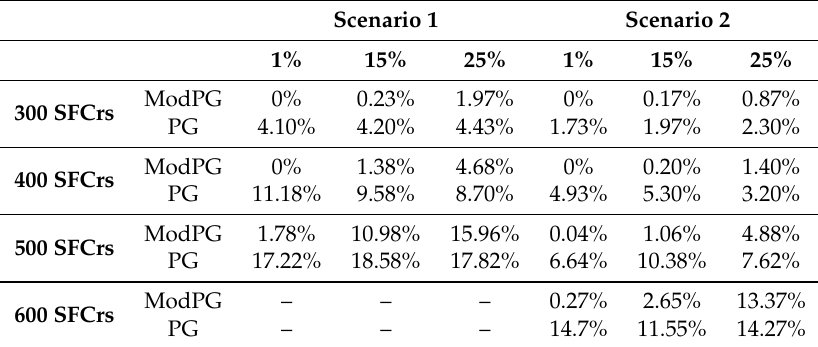
Table 2. Percentage of non-allocated SFCrs: mean